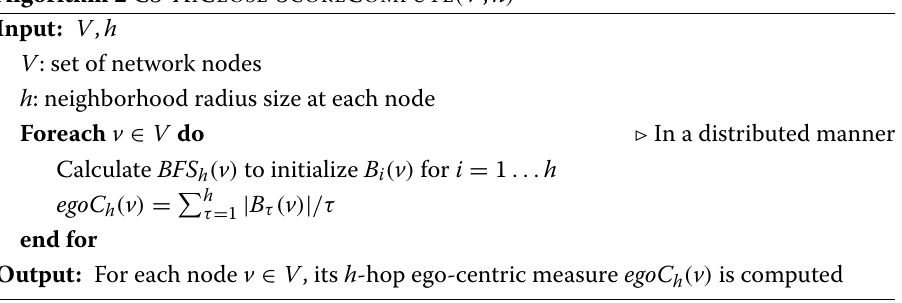
Algorithm 2 CS-H I C LOSE -S CORE C OMPUTE ( V , h )